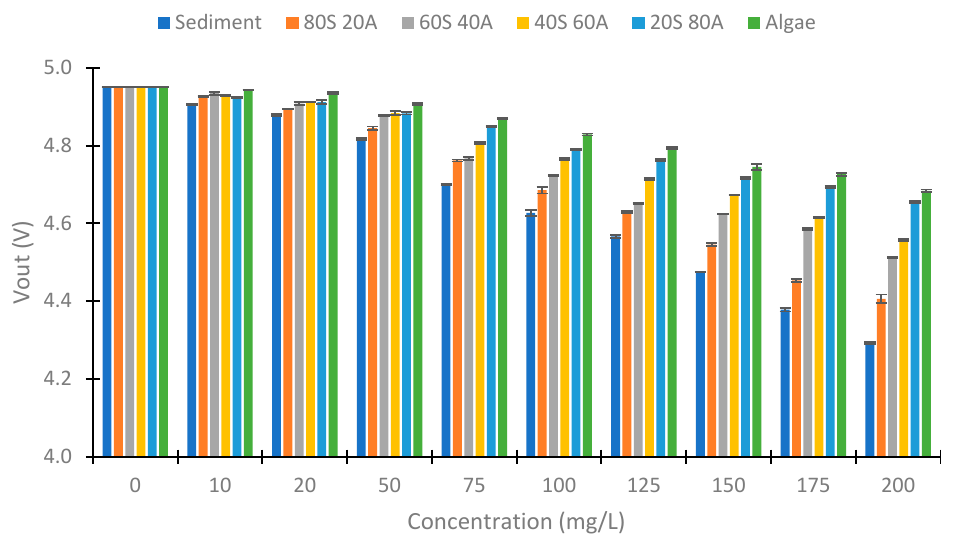
Figure 8. Vout in the voltage divider of the photodiode at 90°.